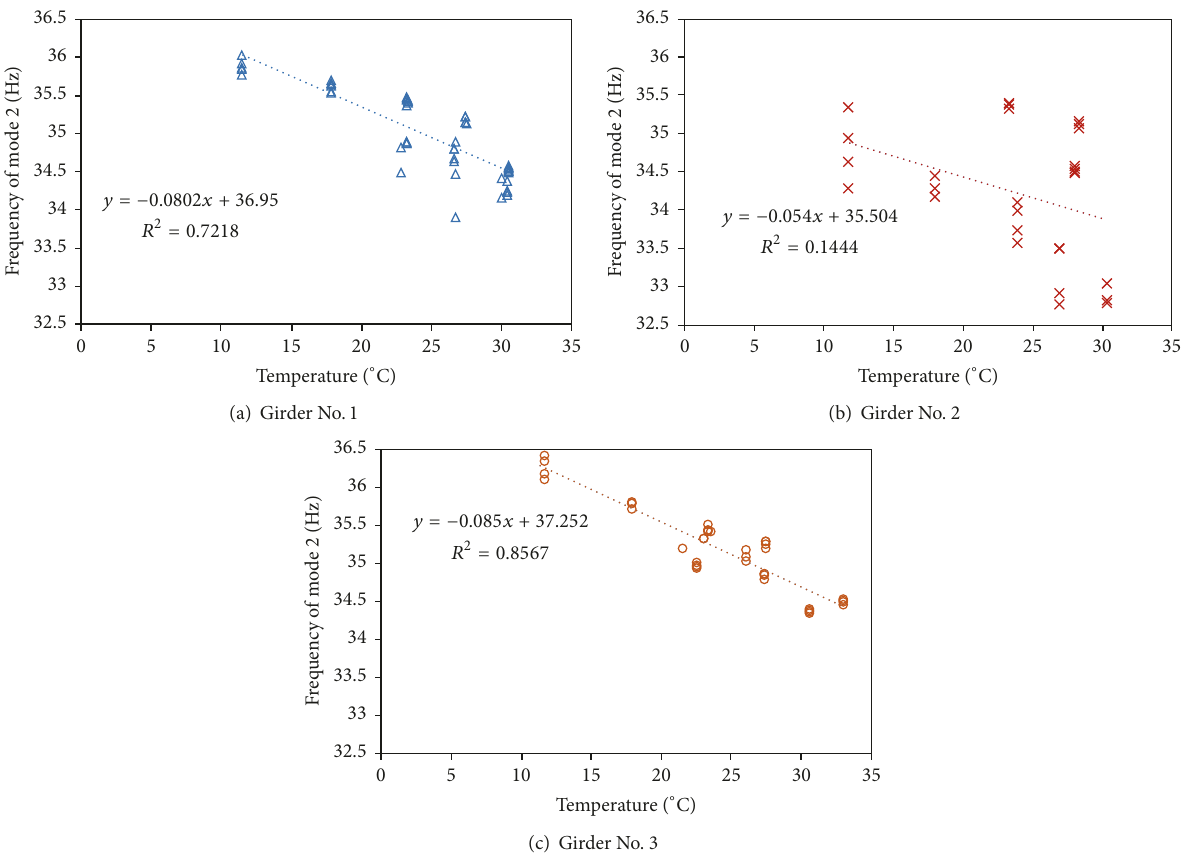
Figure 8: ((a)–(c)) Relation of frequencies of mode 2 to